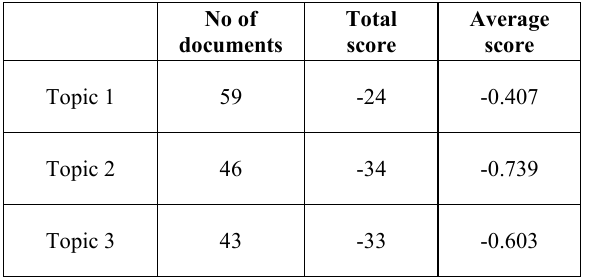
Table 4. Summary statistics on the sentiment score for each topic in